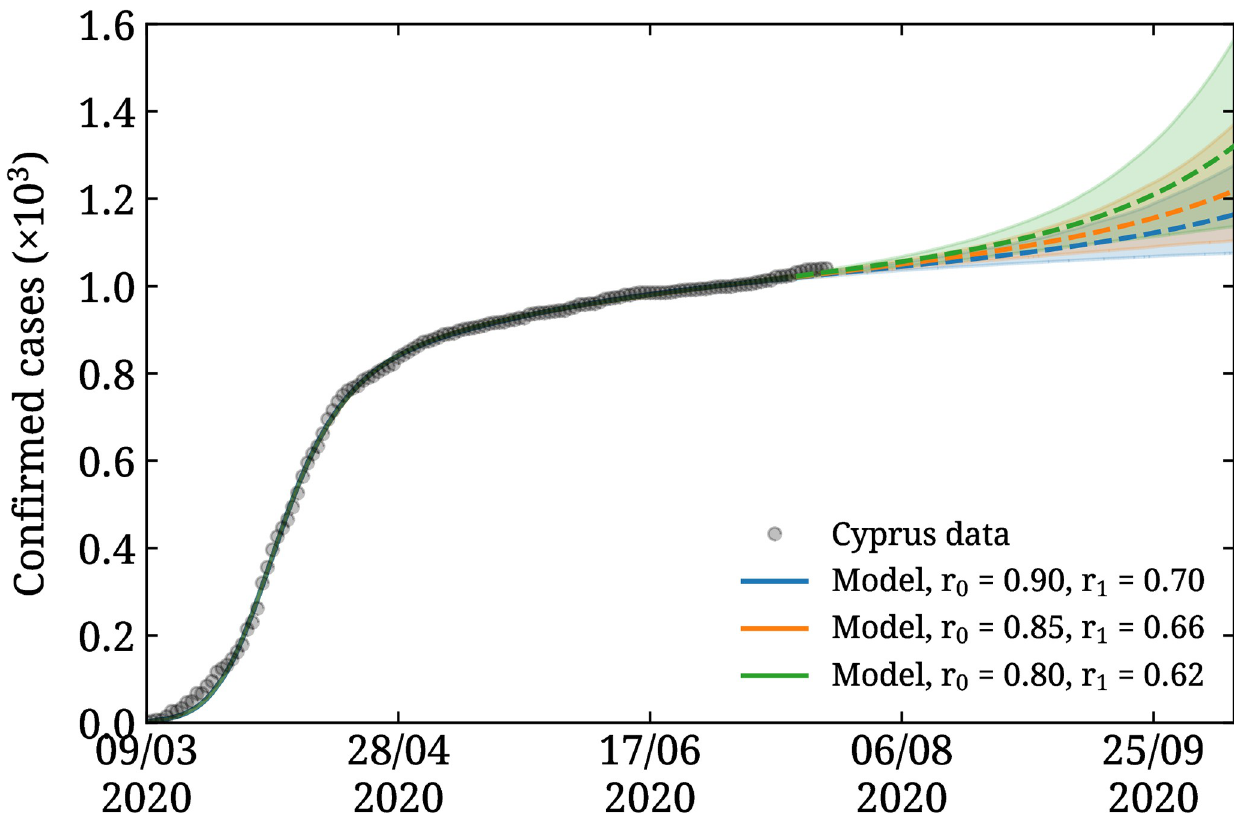
Fig 5. Sensitivity to detection rate. The result of fitting our SEIQR model using ( r 0 , r 1 ) = (0.9, 0.7) (blue curve and band), (0.85, 0.66) (orange curve and band), and (0.80, 0.62) (green curve and band). In all cases the fit includes confirmed cases (black points) until t f = 128 (July 15 th ).